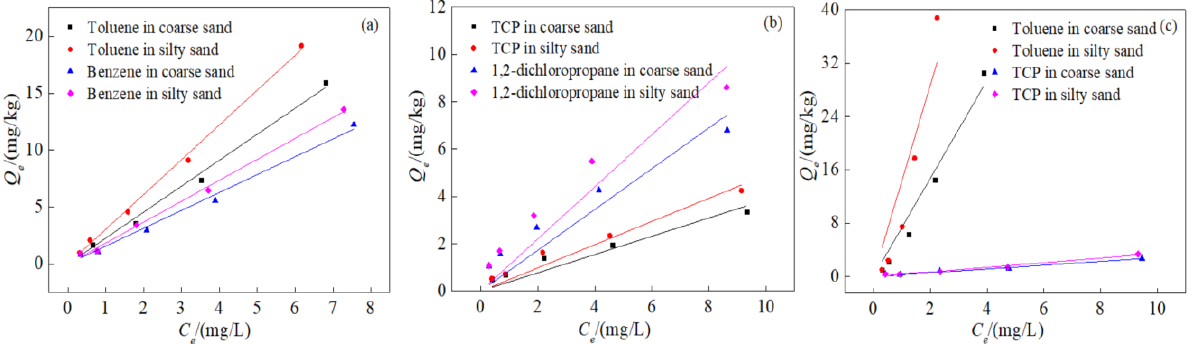
Figure 6. The effect of medium particle size on the competitive adsorption of ( a ) benzene and toluene, ( b ) TCP and 1,2−dichloropropane, and ( c ) toluene and TCP in different two−component systems. (The particle size of medium was 0.5~1 mm and 0.075~0.1 mm).